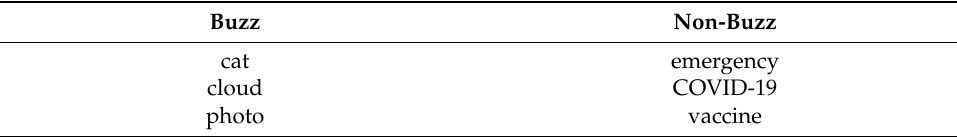
Table 1. Example of keywords for tweet collection.